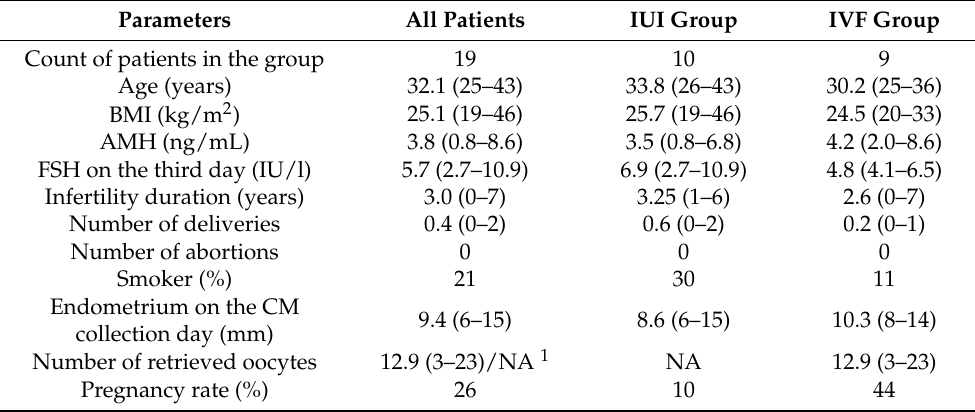
Table 1. Characteristics of the participating patients. Where relevant, values are quoted as means with minima and maxima in parentheses. Age, height, weight and smoker status were obtained during initial visit, AMH and FSH were analyzed from peripheral blood, and endometrial thickness was determined via ultrasound examination at oocyte retrieval procedure. Patients in the IUI group were undergoing intrauterine insemination without hormone stimulation while those in the IVF group were undergoing in vitro fertilization with stimulated cycles. Pregnancy rates were defined as clinically confirmed pregnancy. The population characteristics and hormone levels apply to the date of CM